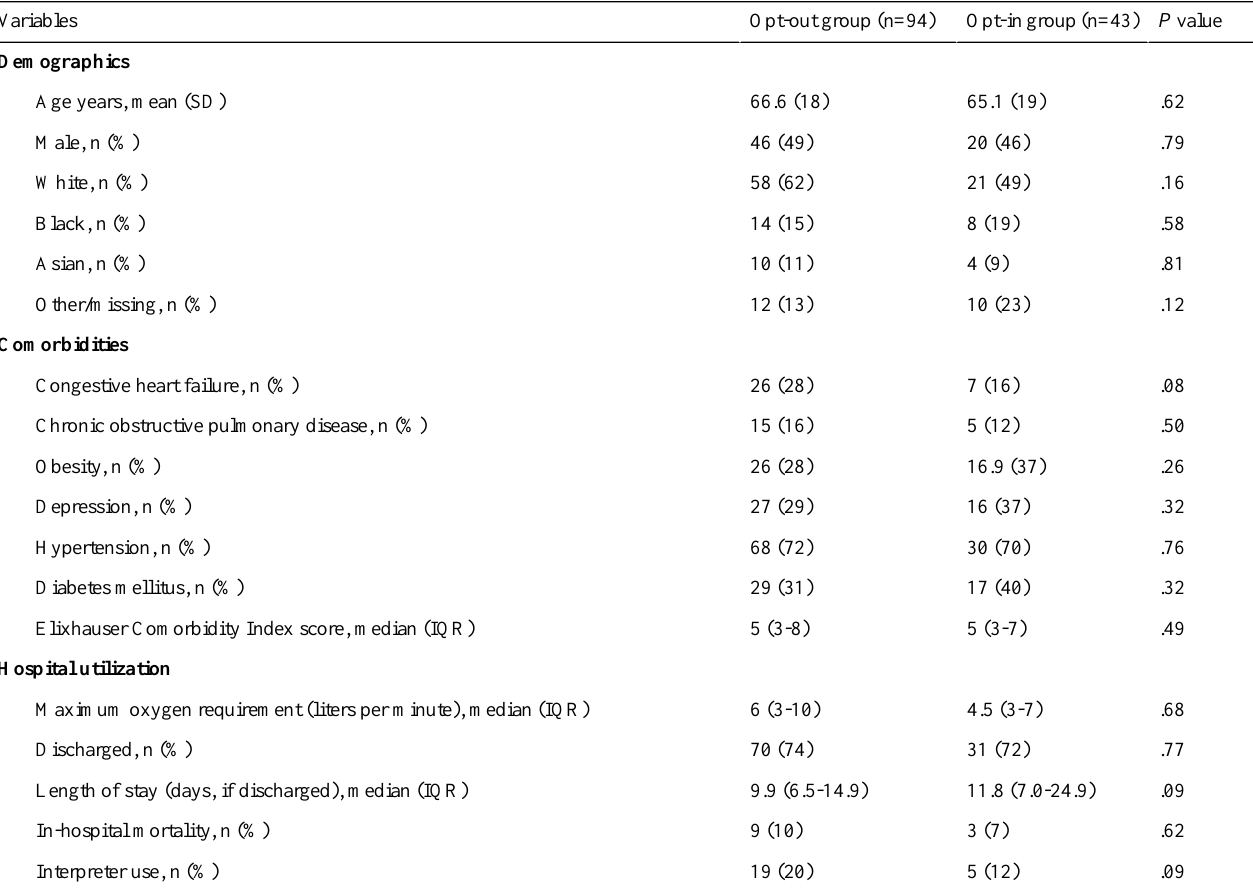
Table 1. Patient demographics, comorbidities, and hospital utilization among patients with and without virtual